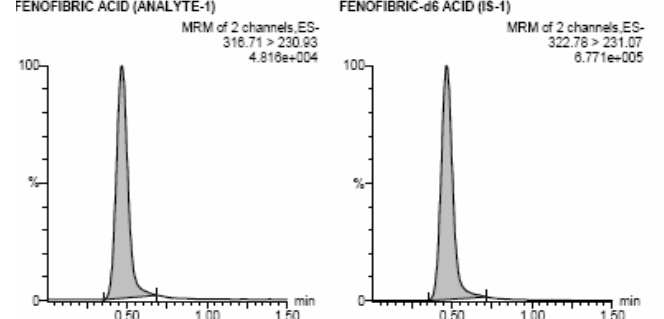
Figure 4. Representative chromatogram of fenofibric acid and its internal standard from extracted plasma at LLOQ